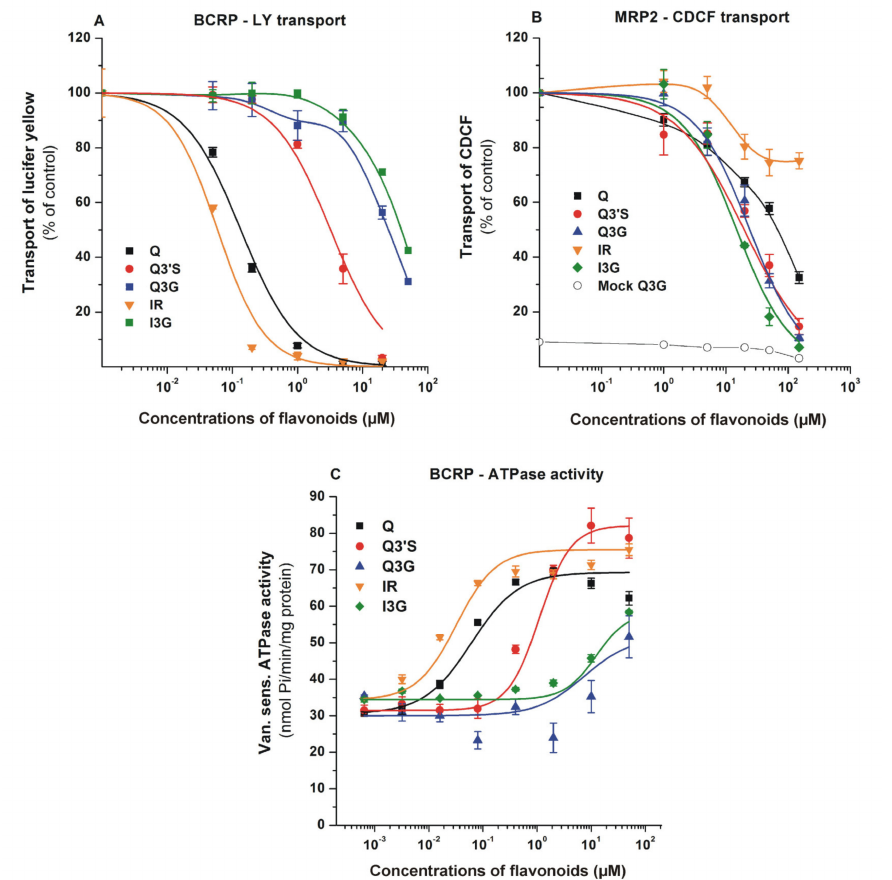
Figure 4. E ff ects of Q and its metabolites on BCRP and MRP2. BCRP transporter function was measured in human transporters containing inverted insect cell membrane vesicles. Transport activity was characterized by vesicular uptake of a specific fluorescent substrate (lucifer yellow (LY) for ABCG2 and 5(6)-carboxy-2 (cid:48) ,7 (cid:48) -dichlorofluorescein (CDCF) for MRP2), where the transport by the ABC transporter is defined as ATP dependent uptake of the substrate into the vesicles. Vanadate sensitive ATPase activity of BCRP was measured by detecting inorganic, deliberated phosphate in a colorimetric reaction. ( A ) E ff ects of flavonoids on the transport of LY by BCRP. Statistically significant ( p < 0.01) decrease in transport was induced by 0.05 µ M of Q, 0.2 µ M of Q3 (cid:48) S, 1.0 µ M of Q3G, 0.05 µ M of IR, and 20 µ M of I3G. ( B ) E ff ects of flavonoids on the transport of CDCF by MRP2. Flavonoid-induced impacts were tested on mock membranes as well, data in the presence of Q3G are demonstrated (data for other flavonoids were identical). Statistically significant ( p < 0.01) decrease in transport was caused by 20 µ M of each flavonoid. ( C ) Changes in the ATPase activity of BCRP in the presence of flavonoids. Statistically significant ( p < 0.01) increase in ATPase activity was induced by 0.08 µ M of Q, 0.4 µ M of Q3 (cid:48) S, 50 µ M of Q3G, 0.02 µ M of IR, and 10 µ M of I3G. Mean ± SEM values were obtained from three biological replicates (Q, quercetin; Q3 (cid:48) S, quercetin-3 (cid:48) -sulfate; Q3G, quercetin-3-glucuronide; IR, isorhamnetin; I3G,